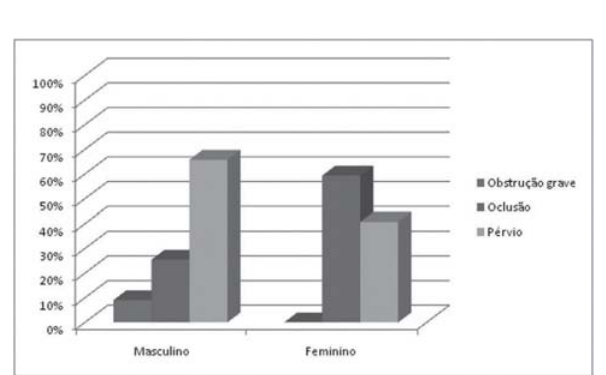
Fig. 3 - Análise entre artéria radial e veia safena anastomosadas na artéria coronária